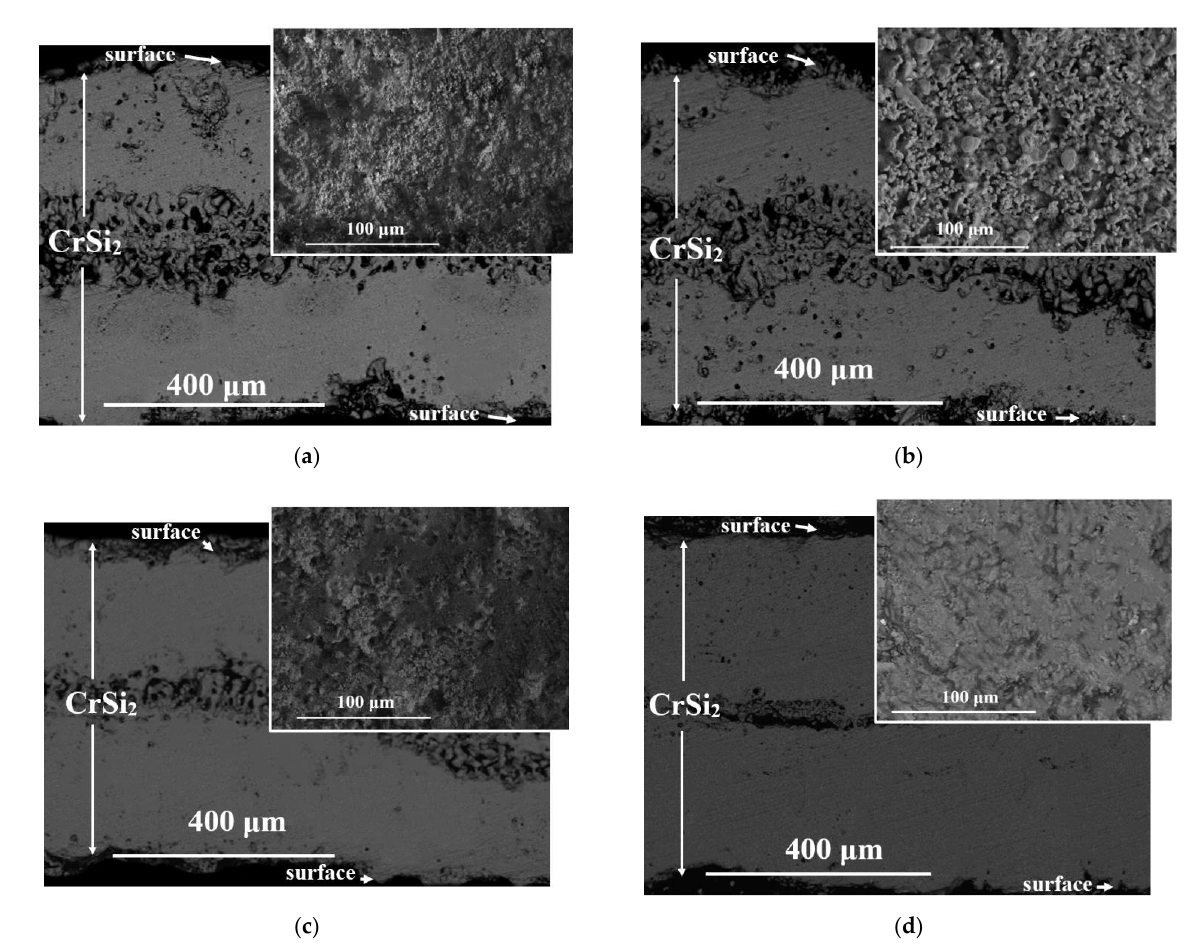
Figure 9. Cross-sectional at 400 μ m and the corresponding plan-view SEM micrographs at 100 μ m (shown inset) of the siliconized samples obtained by use of 15 wt.% Si in the pack mixture for the sample synthesized during the chromizing step at ( a ) 1150_120 min; ( b ) 1000_120 min; ( c ) 1000_30 min; ( d ) 1000_15 min.